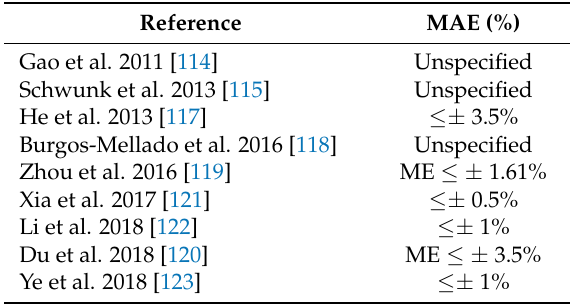
Table 10. MAE/ME of the PF, variants of the PF and hybrid PF-based SOC estimation method.